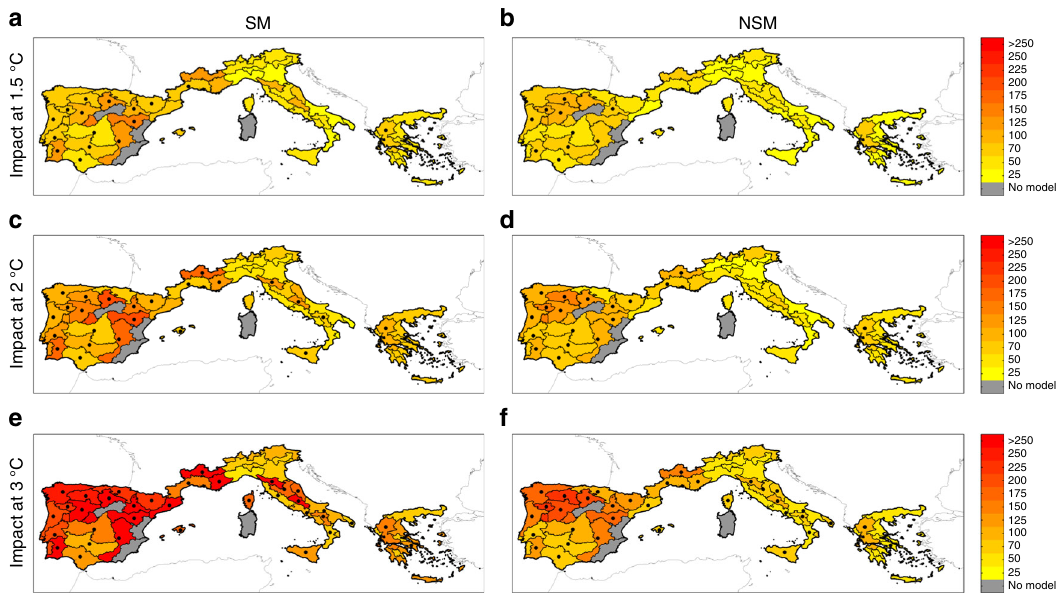
Fig. 4 Ensemble mean burned area changes. Burned area changes (%) for a the + 1.5 °C case with the stationary model SM (i.e., using Eq. 3), ( b ) the + 1.5 °C case with non-stationary model NSM (i.e., NSM). using Eq. (4), ( c ) the + 2 °C case with SM, ( d ) the + 2 °C case with NSM, ( e ) the + 3 °C case with SM, and f the + 3 °C case with NSM. Dots indicate areas where at least 50% of the simulations (1000 bootstrap replications × the ensemble of RCMs) show a statistically signi fi cant change and more than 66% agree on the direction of the change. Coloured areas (without dots) indicate that changes are small compared to natural variations, and white regions (if any) indicate that no agreement between the simulations is found (similar to ref. 70 )